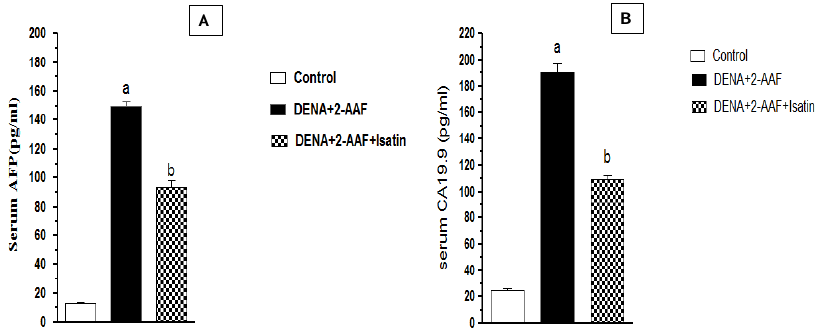
Figure 2. Isatin reduced serum tumor biomarker concentrations in DENA/2-AAF-treated rats. ( A ) Serum AFP concentration. ( B ) Serum CA19.9 concentration. Data are presented as mean ± SEM. a p < 0.05 vs. the control group. b p < 0.05 vs. the DENA/2-AAF-treated group.